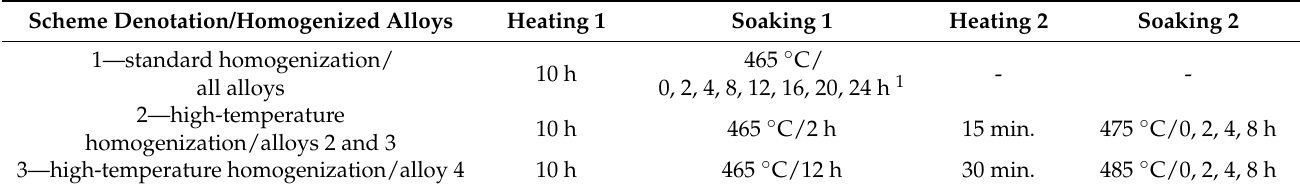
Table 2. Laboratory homogenization conditions applied in stage